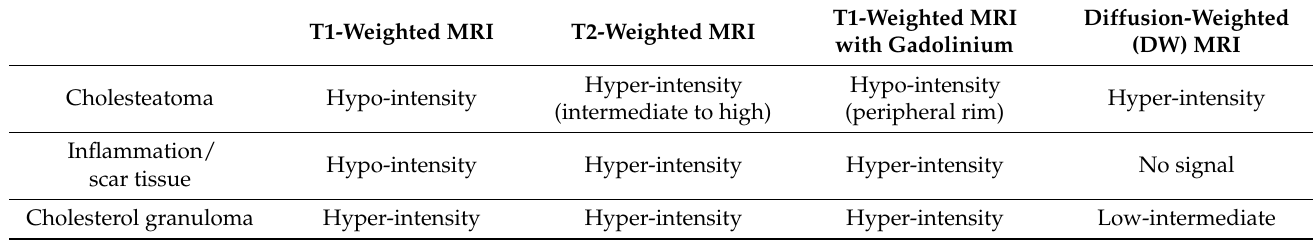
Figure 4. The assessment of cholesteatoma in mastoid cavity with combined DW-T1W-CT imaging. Case ( I ): Mastoiditis. The mastoid lesion has the characteristic of hypo-intensity on DW-MRI and hyper-intensity on T1W-MRI with gadolinium. Case ( II ): Cholesteatoma, confined in mastoid antrum. The mastoid lesion has the characteristic of hyper-intensity on DW-MRI and hypo-intensity and peripheral rim on T1W-MRI with gadolinium, with the extent limited within the mastoid antrum. Case ( III ): Cholesteatoma, extended beyond the mastoid antrum. The mastoid lesion has the characteristics of hyper-intensity on DW-MRI and hypo-intensity and peripheral rim on T1W-MRI with gadolinium, which extends beyond the mastoid antrum and involves the peripheral air cell, semicircular canal, and dura mater. Table 4. Differential diagnosis and imaging characteristics of cholesteatoma on MRI [7] .